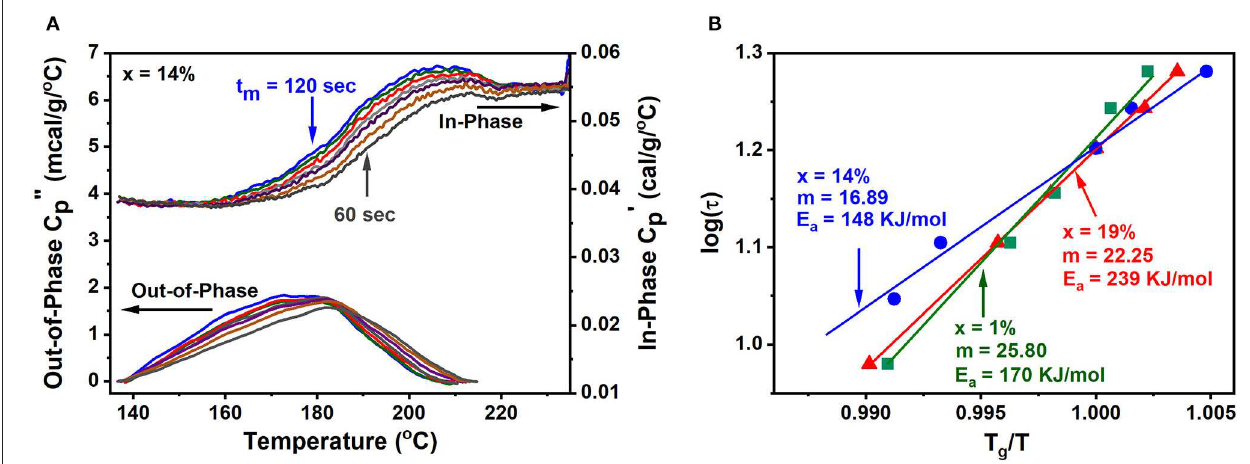
FIGURE 4 | (A) Shows the variation of the C pip and C p op contributions as a function of modulation frequency. As the modulation frequency increases in going from a t m of 120–60s, the C pop peaks corresponding to ω · τ = 1, steadily shifts to higher temperature underscoring the melt has to relax faster ( τ decreases) to track the increased ( ω ) modulated heat flow. (B) Shows a plot of log of τ as a function of T g /T permitting one to deduce the fragility index from the slope (Equation